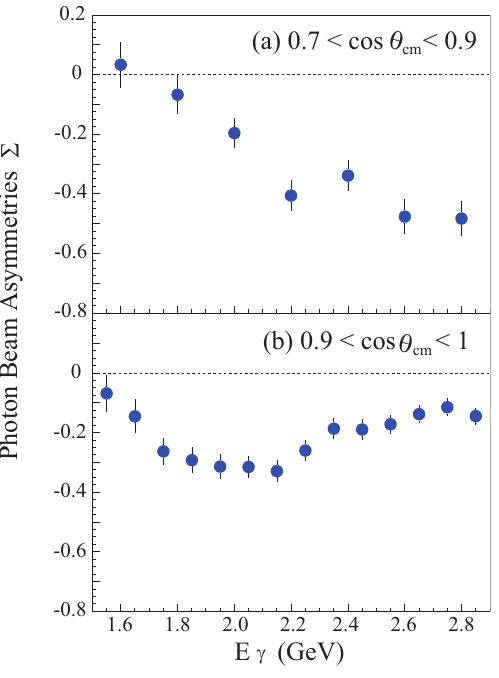
Figure 3. Photon beam asymmetries for the ~γ p → π − ∆ ++ reac- tion for (a) 0.7 < cos θ cm < 0.9 and (b) 0.9 < cos θ cm < 1 [21].